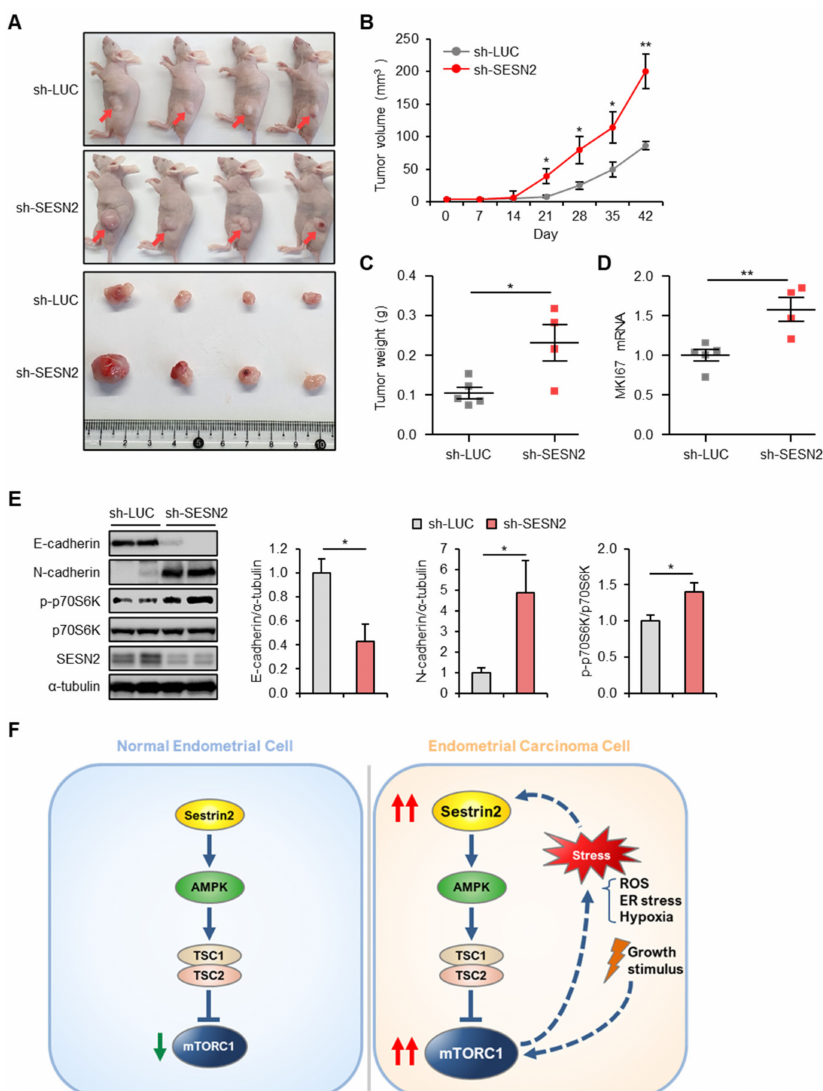
Figure 8. In vivo e ff ects of SESN2 on tumor growth. ( A – E ) HEC-1A cells infected with lentiviruses expressing shRNAs targeting luciferase (sh-LUC, n = 5) or SESN2 (sh-SESN2, n = 4) were subcutaneously injected into nude mice. ( A ) A representative photograph of nude mice at 6 weeks after tumor cell injection. Red arrows indicate the xenograft tumor. ( B ) Tumor growth curve is plotted based on the tumor volume. ( C ) Di ff erences in tumor weight measured while excising the tumors. ( D ) qRT-PCR analysis of MKI67 mRNA levels in tumor tissues from the indicated mice. ( E ) Immunoblotting analysis in tumor lysates from indicated mice with anti-E-cadherin, anti-N-cadherin, anti-p-p70S6K, anti-p70S6K, and anti-SESN2 antibodies. The α -Tubulin served as a loading control. Band intensities were quantified and normalized with α -tubulin values. ( F ) Schematic diagram describing the roles and mechanisms of SESN2 in endometrial cancer. Dashed arrows indicate speculations based on current and previous studies. Data are shown as mean ± SEM. * p < 0.05; ** p < 0.01 (Student’s t